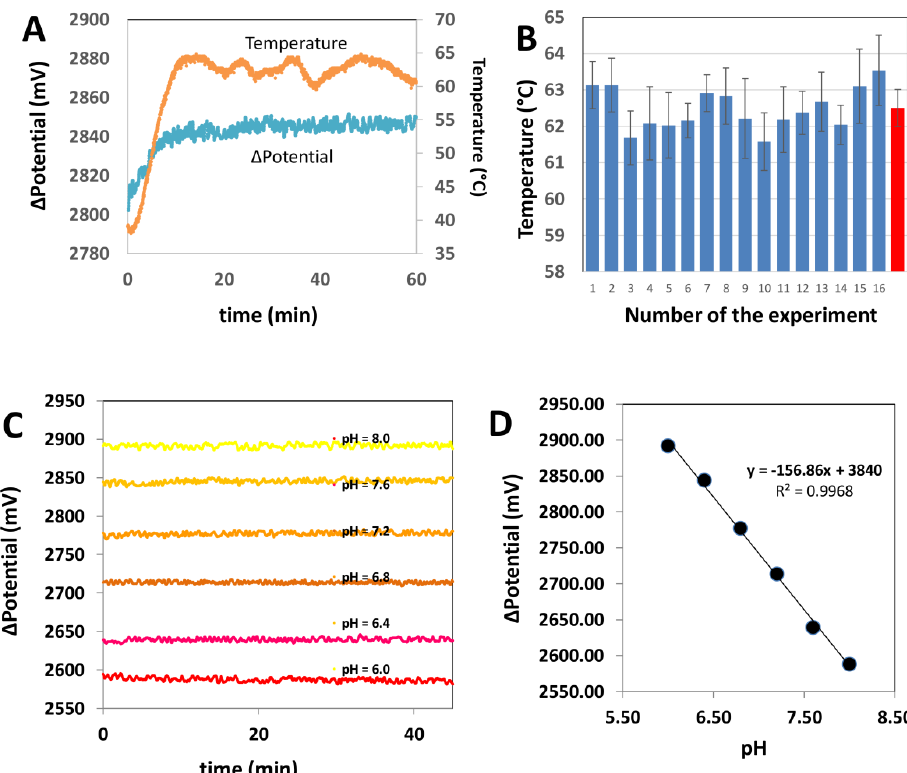
Figure 3. Basic characterization of the electric potential monitoring system and the Arduino-based proportional–integral–derivative (PID) controller. ( A ) The potential differential is stable at isothermal conditions. The evolution of the potential differential is marked in blue. Temperature is marked in orange. ( B ) The Arduino-based PID controller is able to maintain the temperature value around the set point value (62.5 ± 0.5 °C) in a set of 16 independent experiments indicated with blue bars. The red bar indicates the average temperature and standard deviations of this set of 16 independent experiments. ( C ) The potential signal is stable at different pH values in the range of 6.0 to 8.0. ( D ) A linear dependence between pH and potential differential was observed in the entire range of pH values relevant to the Loop-mediated Isothermal Amplification (LAMP) reaction.